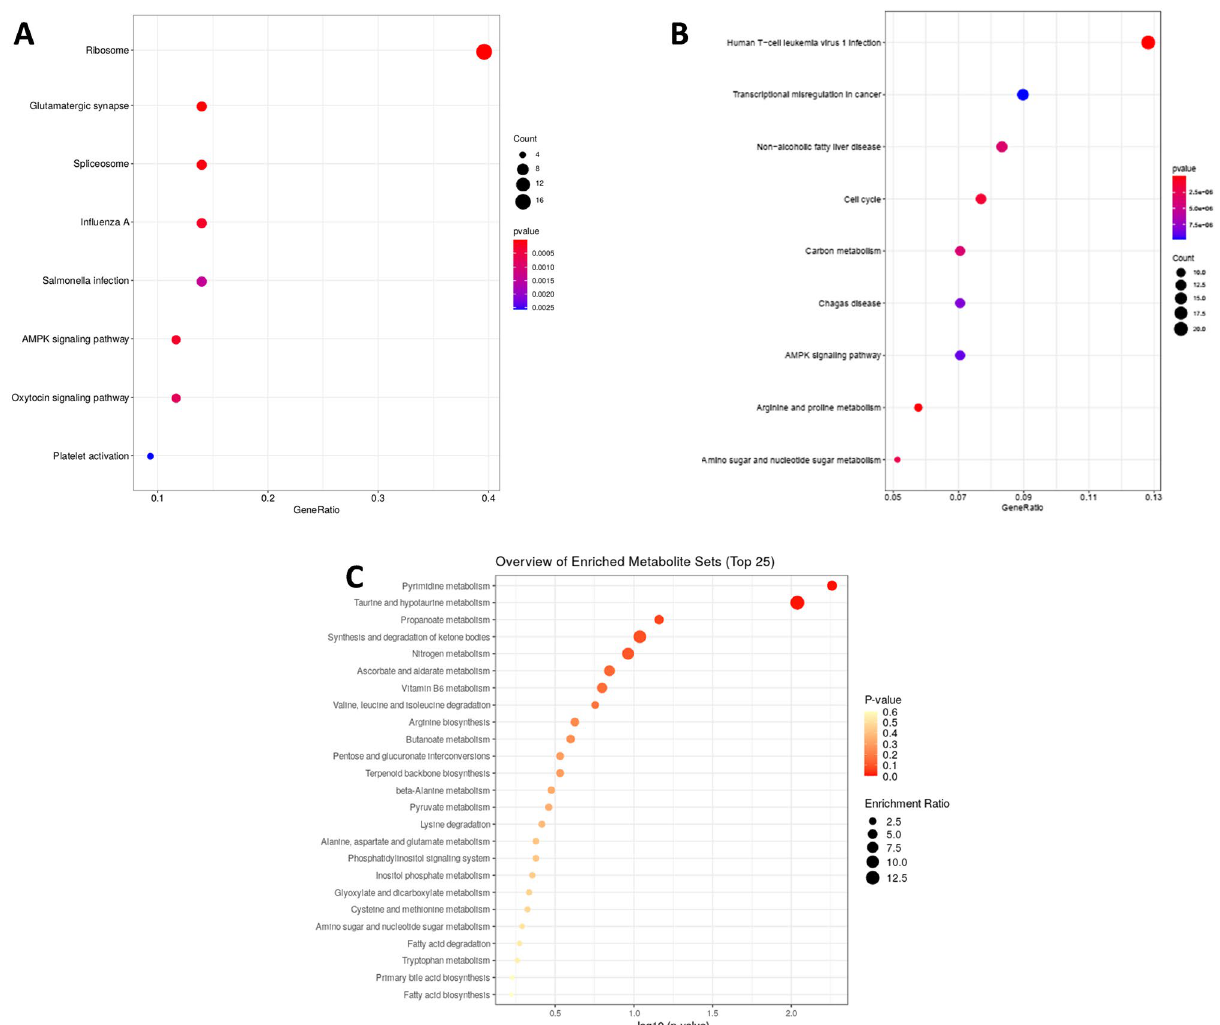
Figure 2. KEGG (Kyoto Encyclopedia of Genes and Genomes) pathway enrichment analysis of dysregulated transcripts ( A ), proteins ( B ) and metabolites ( C ) between high- and low-fertility